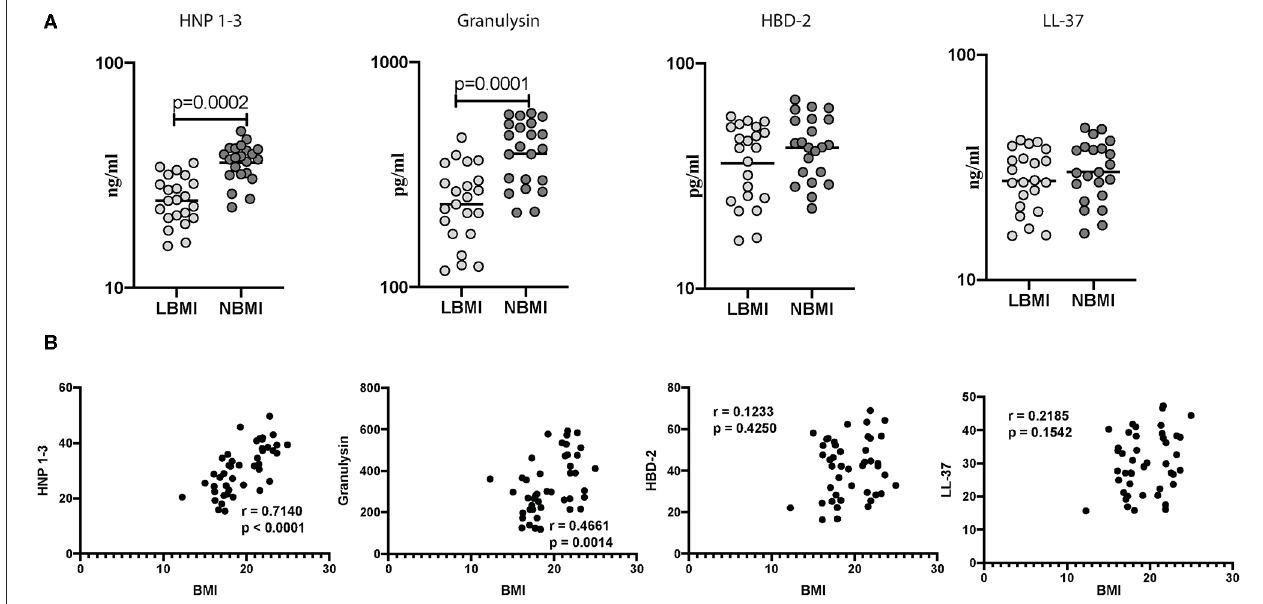
FIGURE 2 | Low BMI is associated with diminished baseline (unstimulated) levels of HNP1-3 and granulysin. (A) The baseline (unstimulated) levels of HNP1-3, granulysin, HBD-2, and cathelicidin (LL37) were measured by ELISA in LTBI-LBMI ( n = 44) and LTBI-NBMI ( n = 44) individuals. The data are depicted as scatter plots and each circle represents a single person. Mann–Whitney U -test with Holms correction for multiple comparisons were done to calculate p -values. (B) Relationship between the levels of HNP1-3, granulysin, HBD-2, and cathelicidin (LL37) and BMI in LTBI individuals. The relationship between the baseline (unstimulated) levels of